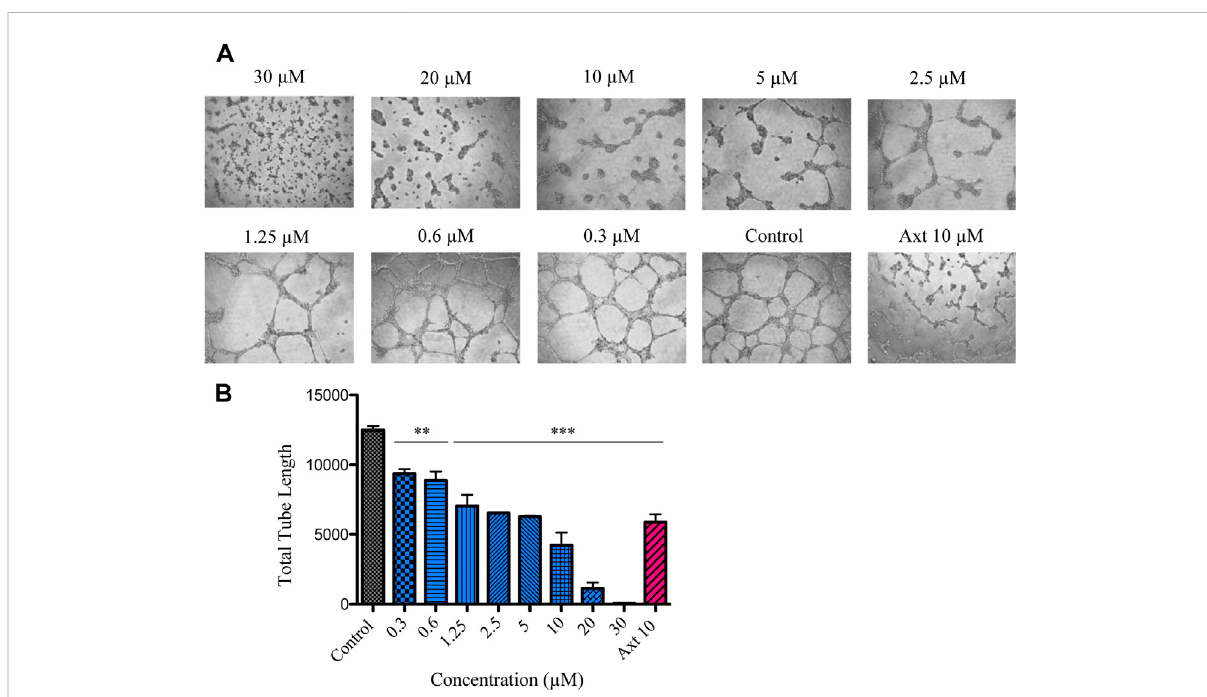
FIGURE 3 Effect of compound 3 on VEGF-induced tube formation in BAECs. (A) Representative images of the tubular networks after treatment with differentconcentrationsofcompound 3 (0.3 – 30 μ M)oraxitinib(Axt,10 μ M). (B) Thecapillary-likestructureswereexaminedandthetubelengthwas quanti fi ed using ImageJ software. The bars show the total tube length expressed as the mean ± SEM. Statistical analysis was performed by ANOVA followed by Dunnett ’ s post-hoc test compared to the negative control (*** p < 0.001, ** p < 0.01).